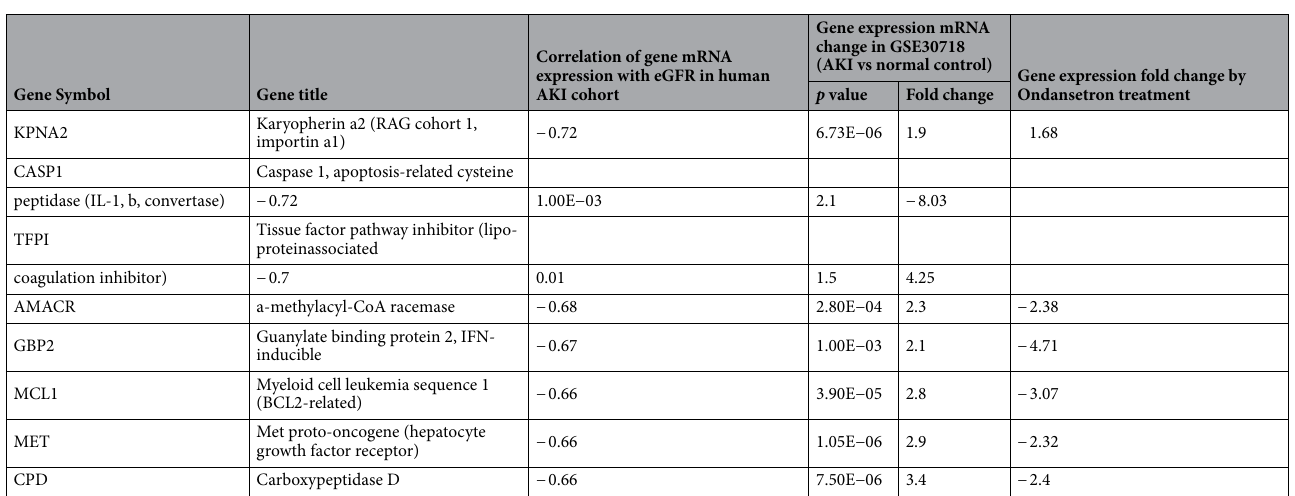
Table 4. Genes whose expressions were negatively correlated with eGFR were also modulated by